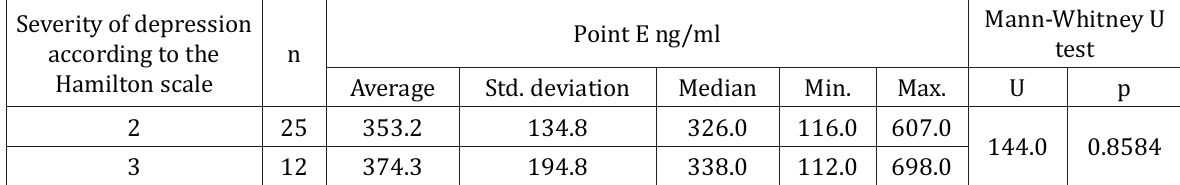
Table 18. Descriptive statistics – Concentration of MMP-9 at the end point of the test in patients with different severity of depression symptoms according to the Hamilton scale and the results of a Mann-Whitney U test